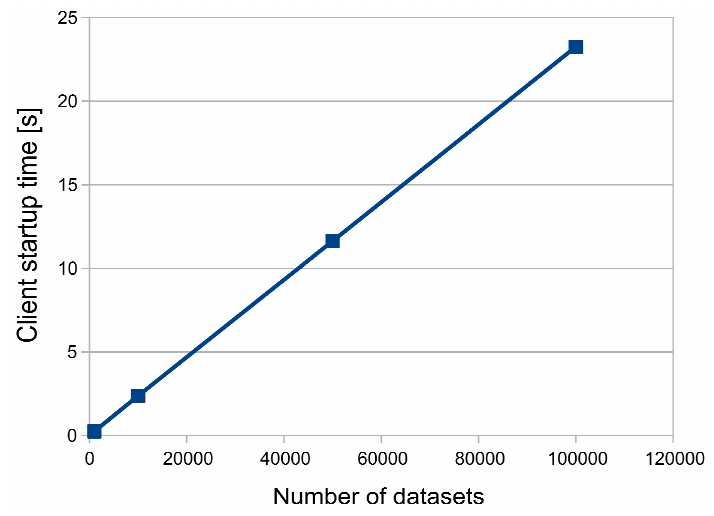
Figure 9. Scaling of client startup time in relation to size of database.